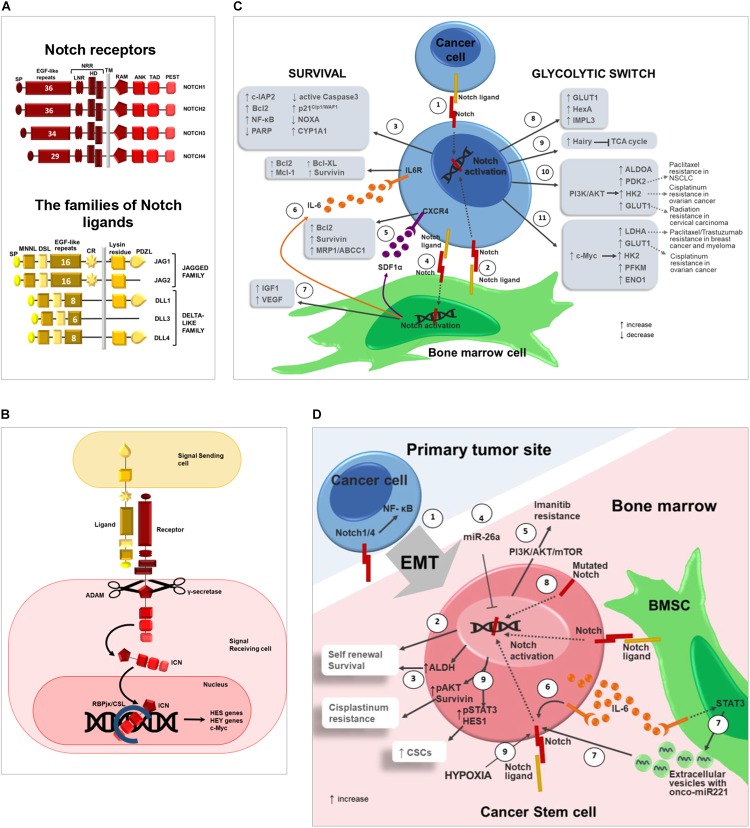
Notch pathway promotes drug resistance by regulating cancer cell survival, glycolytic switch and cancer stem cells. (A) Notch pathway can be triggered by the interaction of 4 receptors (Notch1-4) and 2 different classes of ligands, named Jagged (Jagged1-2) and Delta-like family (Dll1-3-4) (Platonova et al., 2015, 2017a,b). The following domains can be distinguished in Notch receptors: signal peptide (SP); epidermal growth factor(EGF)-like repeats; Negative Regulatory Region (NRR), composed by Lin-Notch repeats (LNR) and heterodimerization domain (HD); transmembrane domain (TM); RBJK associated module (RAM); ankyrin repeats (ANK); transactivation domain (TAD); proline(P),glutamic acid(E),serine(S) and threonine (T) domain (PEST). Jagged and Dll ligands are composed by: signal peptide (SP); Notch ligand N-terminal domain (MNNL); Delta/Serrate/LAG-2 domain (DSL); epidermal growth factor(EGF)-like repeats; cysteine rich region (CR); transmembrane domain (TM); Lysin residues; (PSD-95/Dlg/ZO-1)–ligand motif (PDZL) (Platonova et al., 2017a,b). (B) Canonical Notch signaling: Notch activation is triggered by ligand engagement which enables two consecutive proteolytic cleavages performed by the ADAM metalloproteinase and the γ-secretase complex, that allow ICN to translocate into the nucleus where it binds the RBJK/CSL complex and activates the transcription of Notch target genes such as the HES (Kageyama et al., 2007), and HEY (Weber et al., 2014) family of genes, c-Myc (Sato et al., 2016) and other genes involved in proliferation, survival, differentiation and stemness. (C) Notch role in cancer cell drug resistance. Notch activation in cancer cell can occur through: (1) homotypic interaction with nearby cancer cells or (2) heterotypic interaction with BM cells (i.e., BMSC). (3) Notch ligands localized on the surface of BMSCs activate Notch signaling in tumor cells resulting in increased expression of anti-apoptotic proteins including c-IAP2, Bcl-2, NF-κB and decreased expression of PARP and active Caspase3 (Nwabo Kamdje et al., 2011, 2012; Takam Kamga et al., 2016) with the subsequent development of chemoresistance mechanisms in different tumors as CLL (Nwabo Kamdje et al., 2012), B-ALL (Nwabo Kamdje et al., 2011) and AML (Takam Kamga et al., 2016). Moreover, BMSC-derived Notch ligands may stimulate the expression of p21Cip1/WAF1 and CYP1A1 and downregulate pro-apoptotic NOXA in cancer cells via Notch signaling regulating the development of drug resistance in MM cells (Nefedova et al., 2004, 2008; Xu et al., 2012a,b). (4) On the other hand, also cancer cells may activate Notch signaling in BM cells such as BMSCs, that in turn secrete the following pro-tumoral soluble factors: (5) SDF1α promotes and upregulates Bcl-2, Survivin and MRP1/ABCC1 in MM (Garavelli et al., 2017); (6) IL6 (Colombo et al., 2016) is reported to upregulate anti-apoptotic and pro-survival proteins in tumor cells including Bcl-2, Mcl-1, Bcl-XL, and Survivin (Catlett-Falcone et al., 1999; Shain et al., 2009; Ara and Declerck, 2010); (7) IGF1 and VEGF can contribute to induce drug resistance in hematological and solid tumors (Dias et al., 2002; Belcheva et al., 2004; Zhang et al., 2006; Kuhn et al., 2012; Hua et al., 2014; Nusrat et al., 2016; Bendardaf et al., 2017). Notch pathway may influence tumor cell drug sensitivity also promoting the glycolytic switch by enhancing the expression of glucose transporters and glycolytic enzymes in cancer cells. (8) In D. melanogaster Notch signaling was found to regulate GLUT1, HexA and IMPL3 and (9) suppress TCA cycle via the upregulation of Hairy gene (Slaninova et al., 2016). (10) In breast cancer Notch signaling induces PI3K/AKT activation that leads to the upregulation of glycolytic enzymes such as ALDOA, PDK2, HK2, and GLUT1 (Landor et al., 2011). Notably, BM adipocytes enhance the expression of two acknowledged Notch downstream effectors, i.e., HK2 and GLUT1, in prostate cancer cells (Diedrich et al., 2016). (11) In CLL, Notch pathway activation induces c-Myc upregulation and the subsequent increased expression of LDHA, GLUT1, HK2, PFKM, and ENO1 (Dang et al., 2009). Finally, wherever possible, for each Notch downstream effector involved in cancer cell glycolytic switch, it is reported the recognized outcome in drug and radiation resistance (Zhao et al., 2011; Huang et al., 2014; Lin et al., 2015; Sun et al., 2017; Zhang et al., 2018). (D) Notch in cancer stem cells: (1) Notch signaling promotes cancer cell EMT, which is closely associated to stemness. For instance, Notch1 and Notch4 expression in prostate cancer cells promotes EMT via NF-κB activation. EMT also enables cancer cell dissemination throughout the body including BM (Shibue and Weinberg, 2017; Zhang L. et al., 2017; Lin et al., 2018). (2) At BM level, Notch pathway activation in CSCs can be mediated by homotypic or heterotypic interactions and positively regulates tumor cell self-renewal, resulting in the amplification of the CSC population characterized by intrinsic high pharmacological resistance. (3) In OS cell, Notch activation boosts the expression of ALDH (Mu et al., 2013), a CSC marker also associated with drug resistance due to its detoxifying activity (Honoki et al., 2010). (4) miR-26a inhibits self-renewal by down-regulating Jagged1/Notch signaling (Lu J. et al., 2017). (5) In CLL, Notch activation results in resistance to Imatinib mediated by PI3K/AKT/mTOR signaling (Aljedai et al., 2015). (6) In BM microenvironment, tumor-derived IL-6 promotes an autocrine upregulation of Notch3, that in turn supports CSC survival and self-renewal (Sansone et al., 2016). (7) Moreover, IL-6 triggers STAT3 signaling in BMSCs improving the secretion of extracellular vesicles carrying the onco-miR221; this, in turn, increases Notch3 expression in CSCs and hormonal therapy resistance in bone metastasis of luminal breast cancer (Sansone et al., 2017). (8) In NSCLC, activating mutations of Notch1 correlate with CSCs and poor prognosis in patients (Westhoff et al., 2009). (9) In NSCLC, hypoxia-induced Notch1 activation promotes CSC self-renewal via pSTAT3 and HES1 and cis-platinum resistance through the positive regulation of pAKT and Survivin (Zhang Y. et al., 2017).